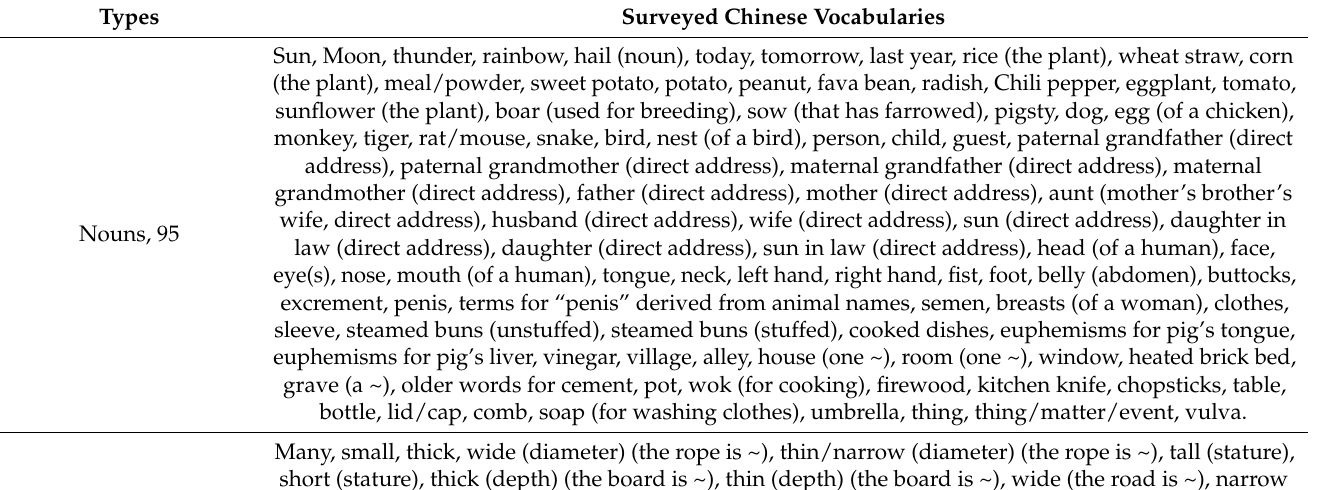
Table A2. Vocabularies of Chinese dialects surveyed by the Linguistic Atlas of Chinese Dialects · Lexicon